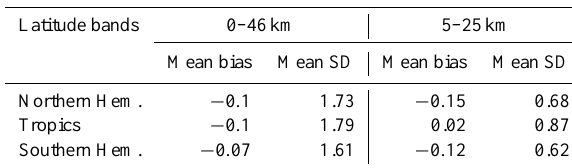
Table 4. Mean bias and standard deviation (SD) of refractivity with respect to ECMWF reanalysis for GNOS GPS in different latitude bands from 1 November to 31 December